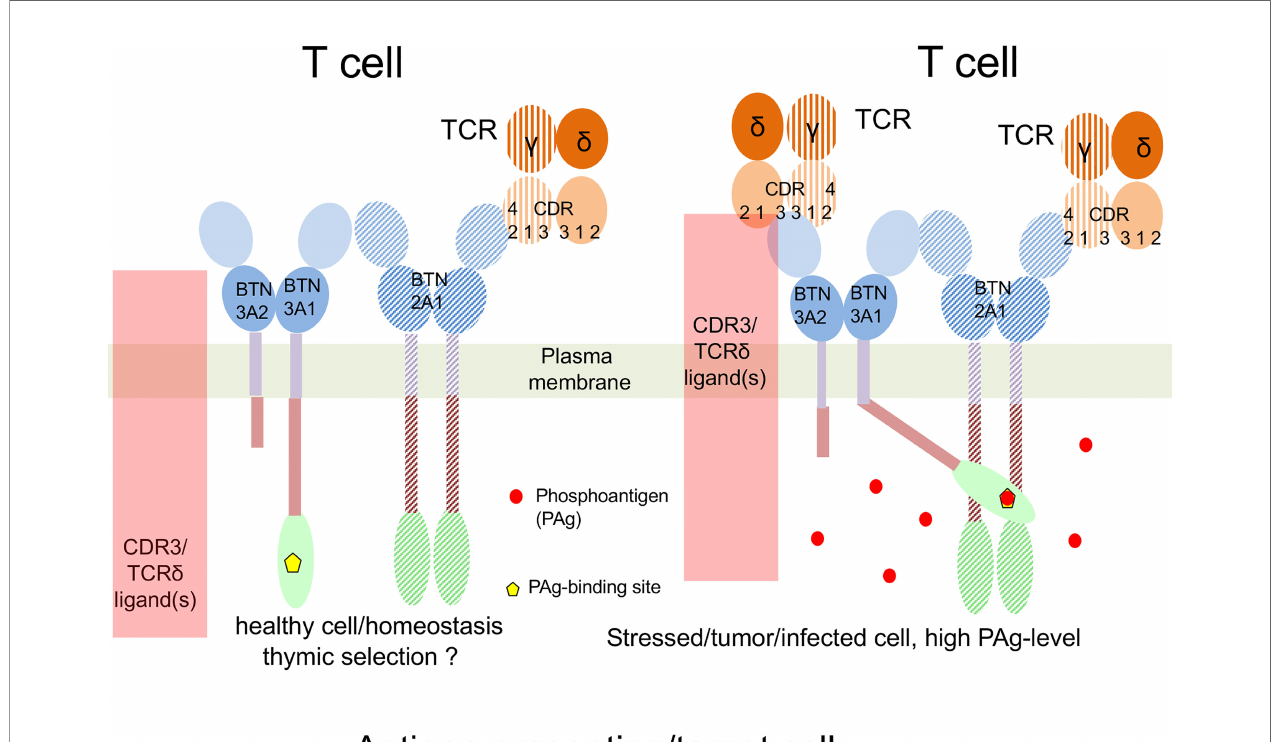
FIGURE 2 | Working hypothesis on PAg-recognition by V g 9V d 2 T cells. Left: Under physiological conditions, BTN2A1 binds to the hypervariable region 4 (CDR4 or HV4) of the V g 9 region of the V g 9V d 2TCR. This controls thymic development and homeostasis of V g 9V d 2 T cells. Right: Infection or cell transformation increases PAg-levels in the presenting or tumor cell. This leads to PAg-binding to the B30.2 domain of BTN3A1, and subsequent binding of the B30.2-PAg complex to the intracellular domain of BTN2A1. The resulting complex might include additional proteins, which fi nally bind all CDRs regions of g and d chain and trigger V g 9V d 2 T cell activation. Please note that so far neither direct binding of the TCR to BTN3A nor existence of an additional ligand recruited by the PAg-binding BTN3A has been